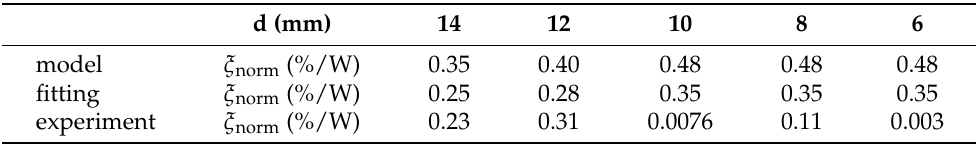
Table 1. Characteristics of the AO modulator of the THz radiation with fully electroded ultrasound transducer obtained in